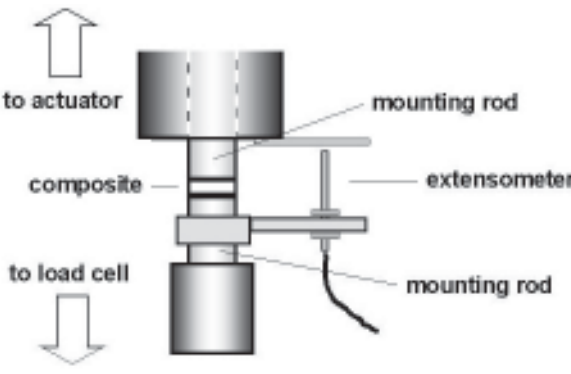
FIGURE 1 - Diagram of the contraction stress test